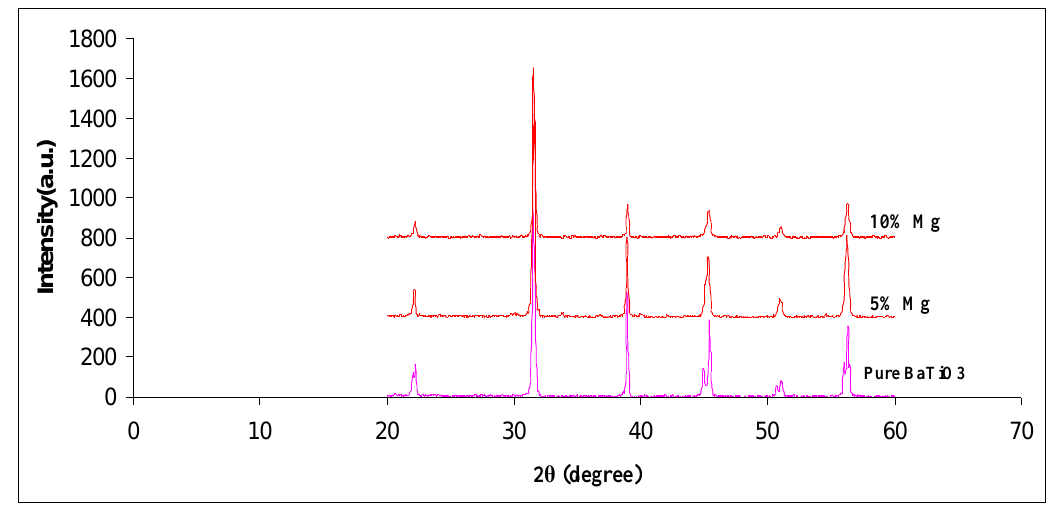
Fig. 10: XRD for BaTiO